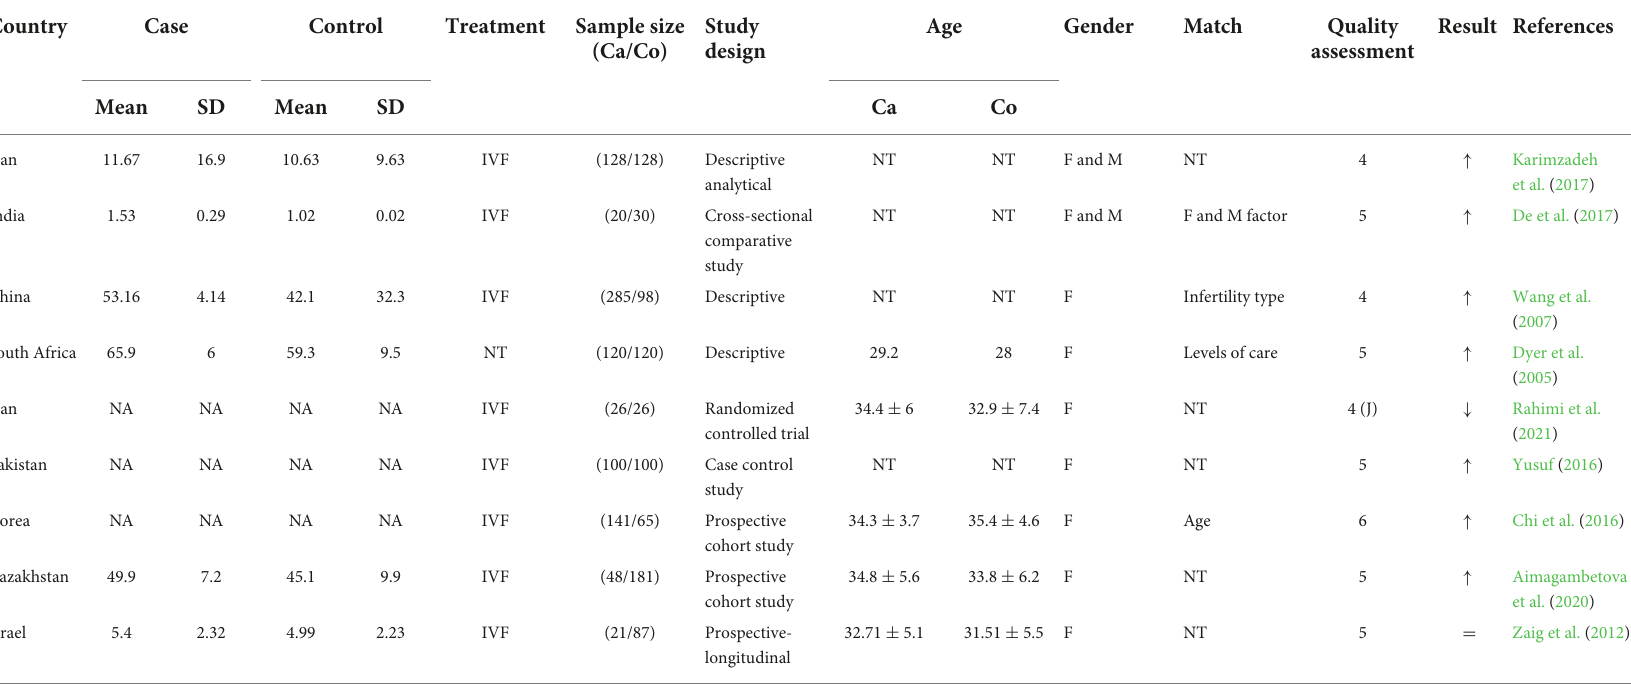
TABLE 5 General characteristics of included studies in the meta-analysis.